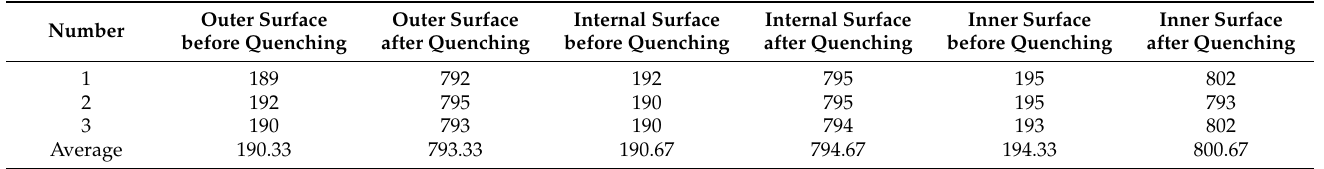
Table 2. Bearing outer ring outer surface hardness results in the experiment (HV).